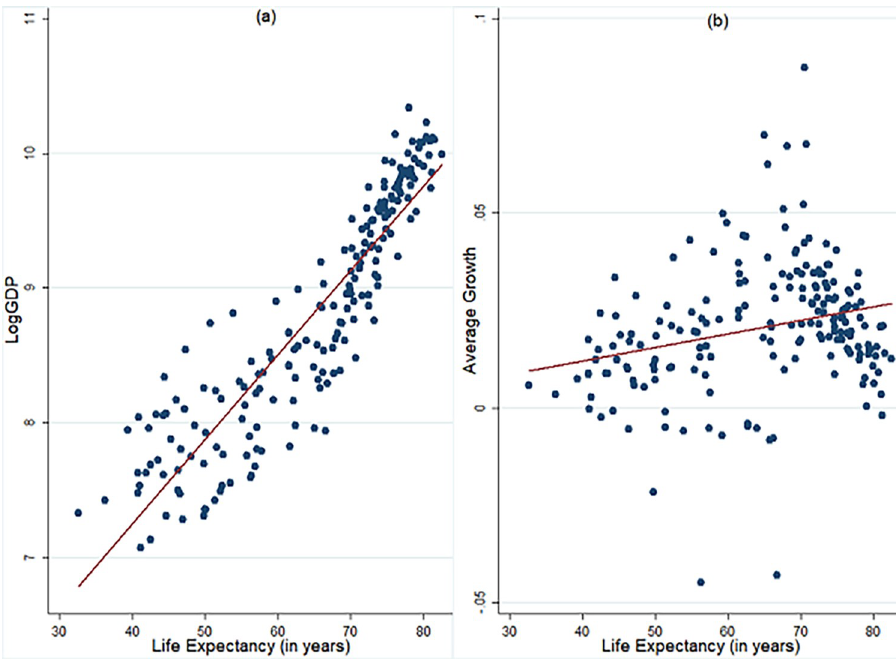
Fig 3. Relationship between average life expectancy and per capita income, growth. a) Scatter plot between LogGDP and Life Expectancy b) Scatter plot between Growth and Life Expectancy. LogGDP is the natural logarithm of real per capita income (at PPP prices). Growth: Growth rate of real per capita income calculated as difference of natural logarithm of real per capita income. Life Expectancy: Life Expectancy at Birth (in years). The data presented here is ten-year